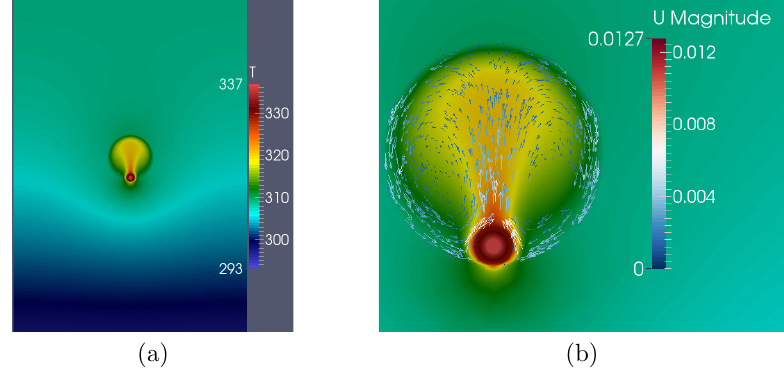
Figure 4. Simulation results for a single cable in a pipe: (a) distribution of temperature, (b) distribution of velocity